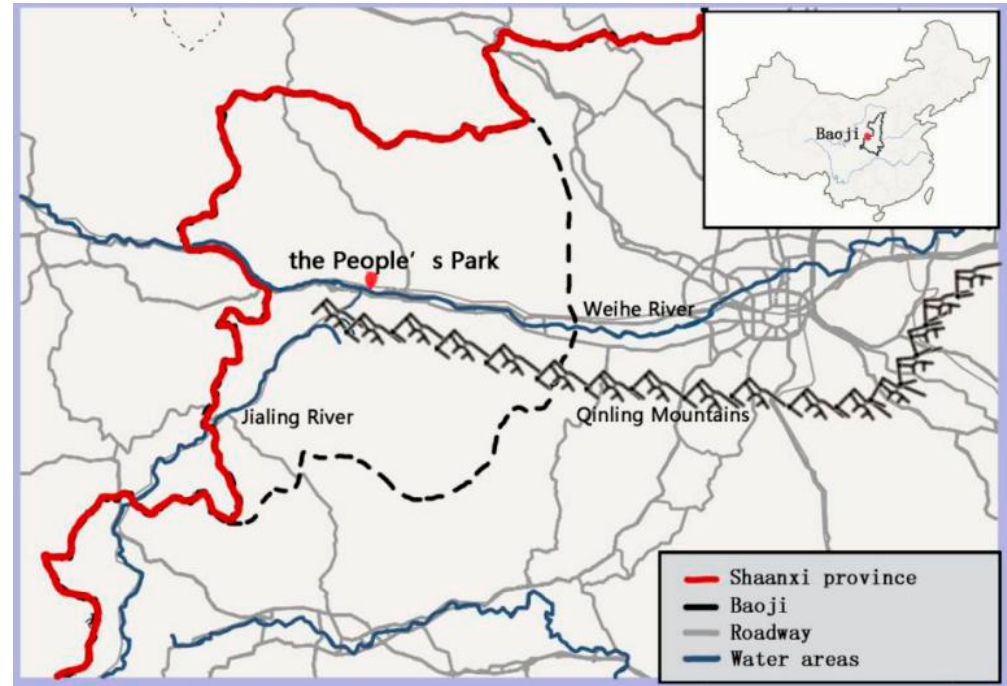
Figure 1. Location of the People’s Park in Baoji city near the Qinling Mountains, Weihe River and Jialing River in Shaanxi, China.